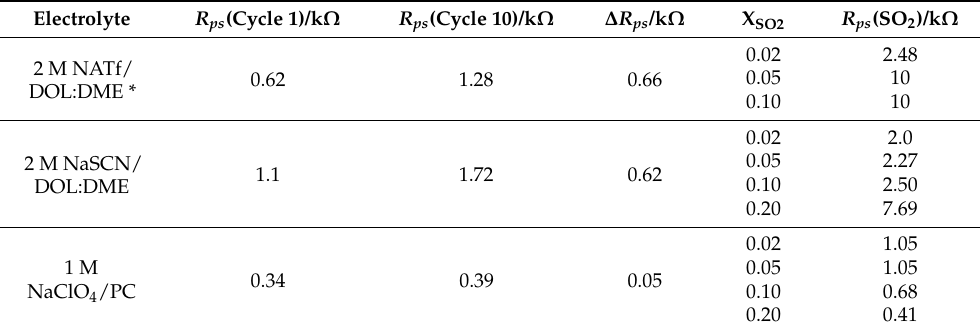
Table 1. Plating-stripping resistance for sodium anodes in contact with three different electrolytes. Values for cycles 1 and 10 are given, together with the corresponding variation ( ∆ R ps ). Plating- stripping resistance (cycle 10) is also given upon the addition of different mole fractions of sulfur dioxide. * NaTf concentration was 1.6 M in the presence of SO 2 . R ps (Cycle 1)/k